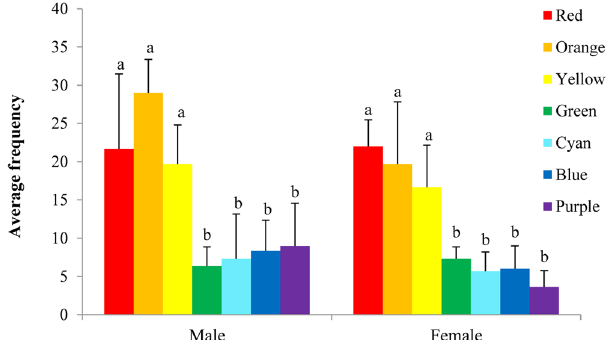
Figure 5. The number of male and female visits to seven butterfly-shaped cut-outs. Different letters above bars indicate significantly different at P < 0.05 significance